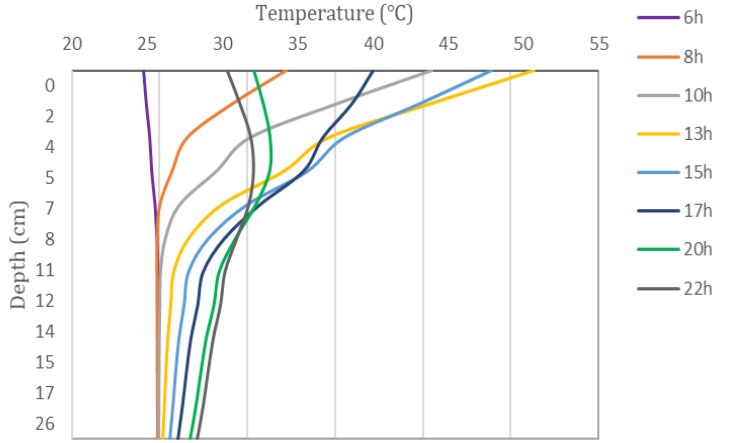
Figure 5. Temperature profiles of the asphalt layers along pavement depth at different moments in the summer.